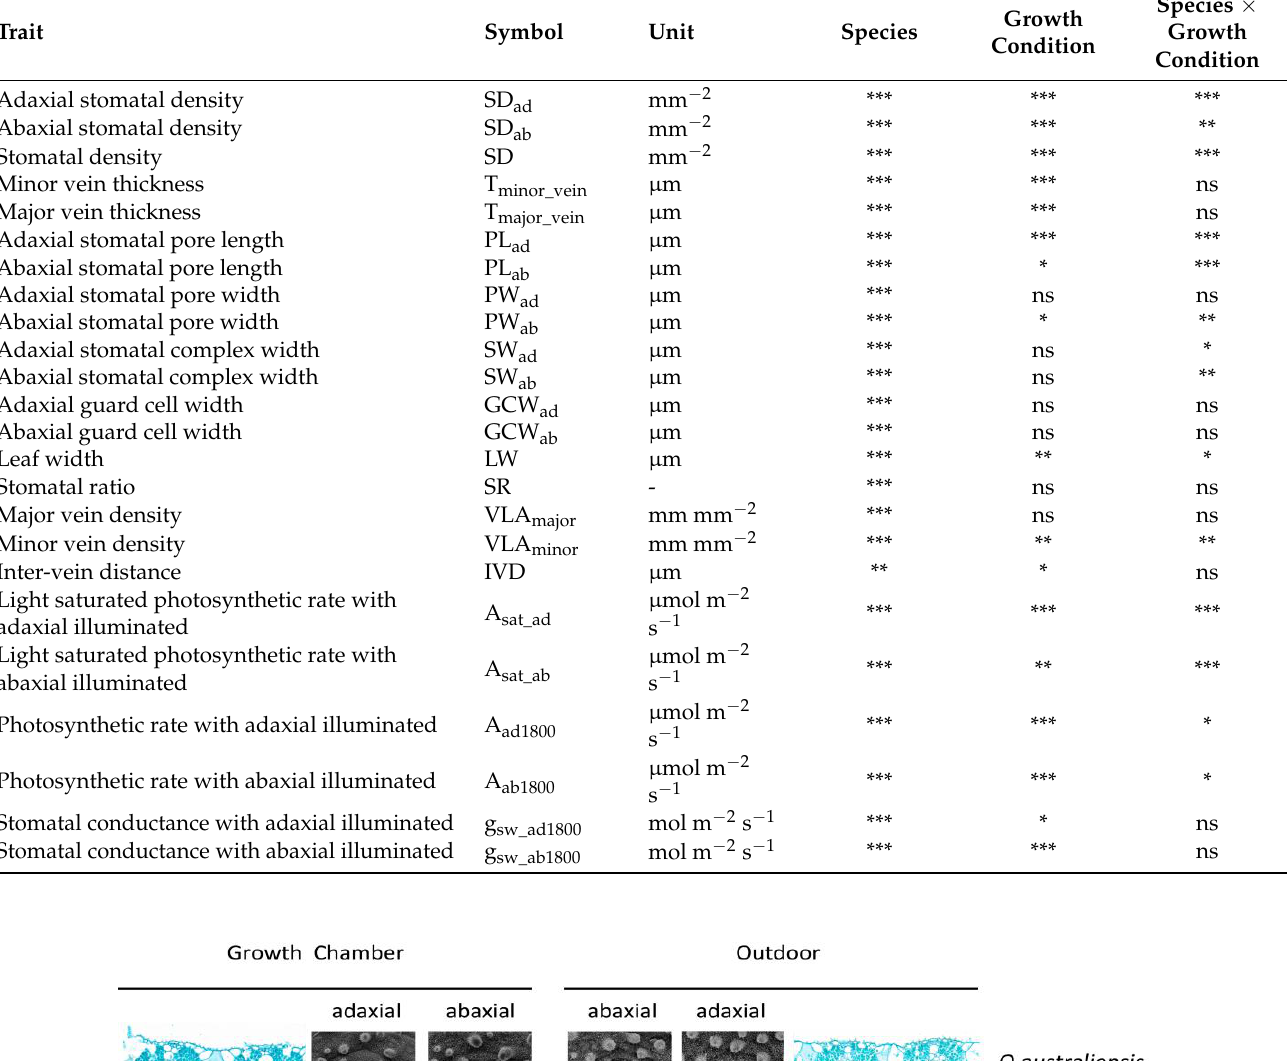
Table 1. Leaf traits for five Oryza species, with expected plastic and adaptive responses to growth conditions (outdoors and in the growth chamber), and results of the ANOVA testing the effects of species differences, growth condition, and their interaction. ns, p > 0.05; *, p < 0.05; **, p < 0.01; ***, p < 0.001.